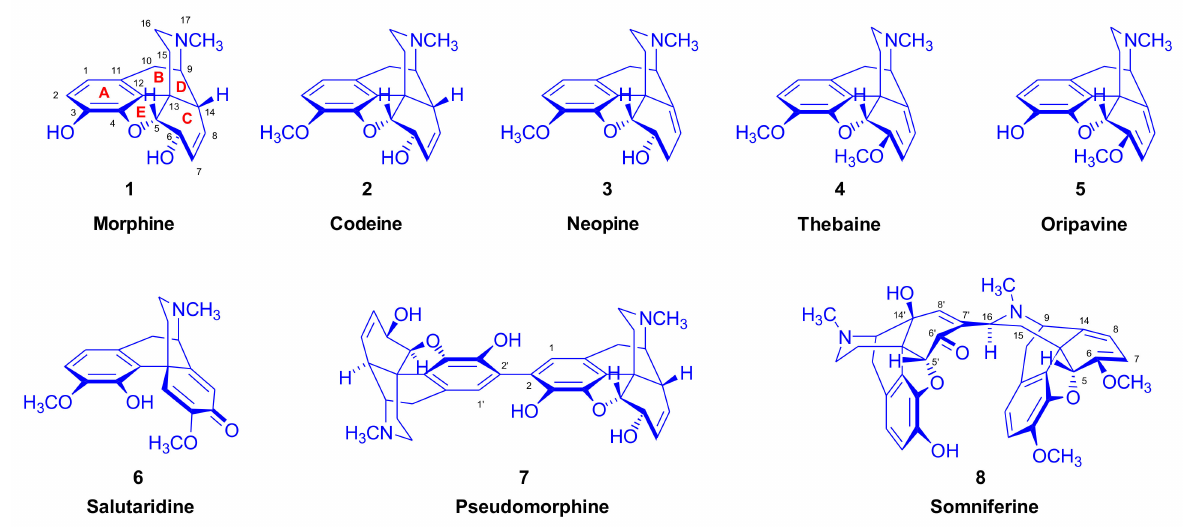
Figure 1. Chemical structure of selected poppy alkaloids with morphinan